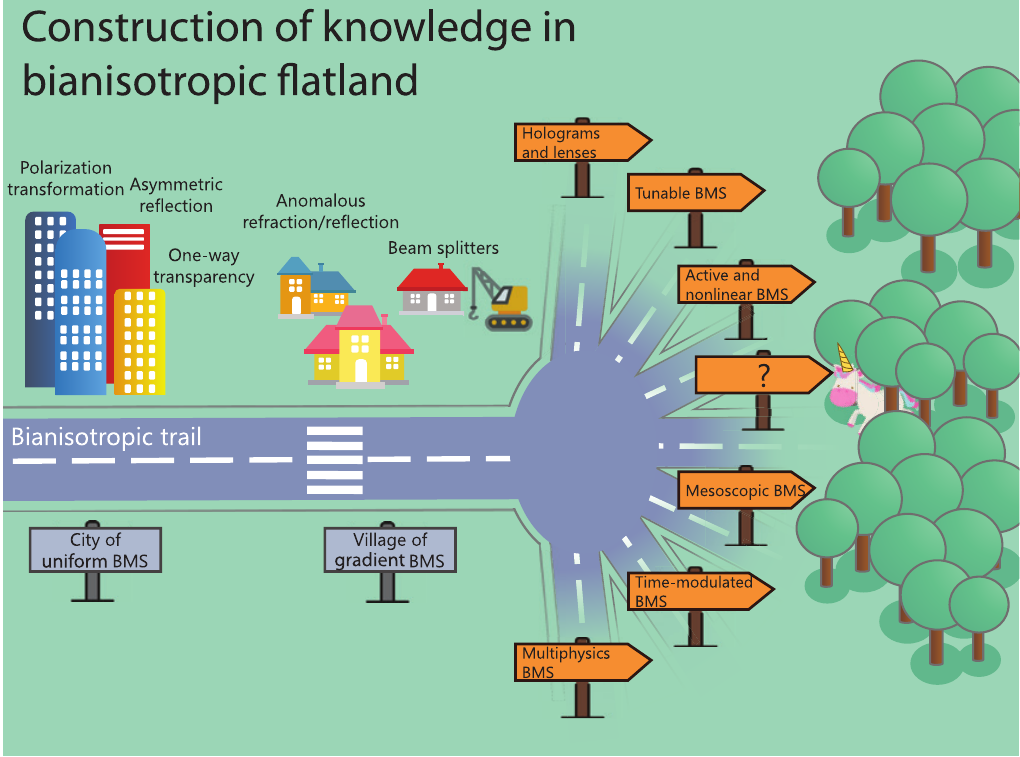
Figure 15: Illustration of the evolution of the knowledge on bianisotropic metasurfaces (BMS) and its prospective research directions. Bianisotropic flatland represents all the possible functionalities offered by the most general linear metasurfaces. In bianisotropic flatland, our knowledge is represented by man-made constructions: the complex city represents the well-studied research directions, whereas the village represents recent ideas and studies that have not been fully analyzed yet. In contrast, the mysterious forest with the unicorn symbol- izes emerging but not yet explored research directions on bianisotropic metasurfaces and their